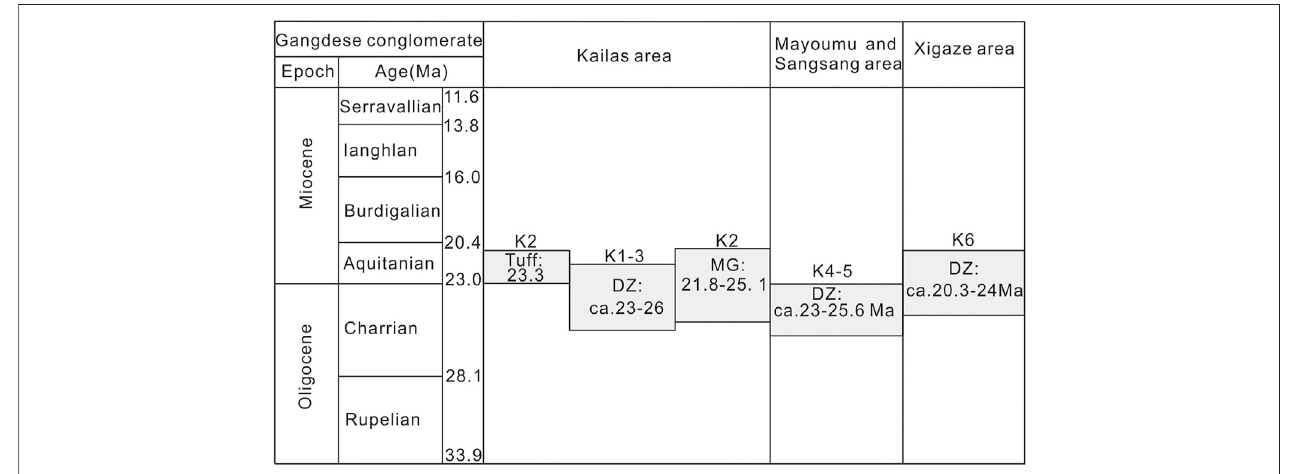
FIGURE 5 | Chronostratigraphy framework of Gangdese conglomerate. Tuff: Tuff layer age; DZ: youngest detrital zircon age; MG: magnetostratigraphy (Tuff and MG age from Ai et al., 2019).